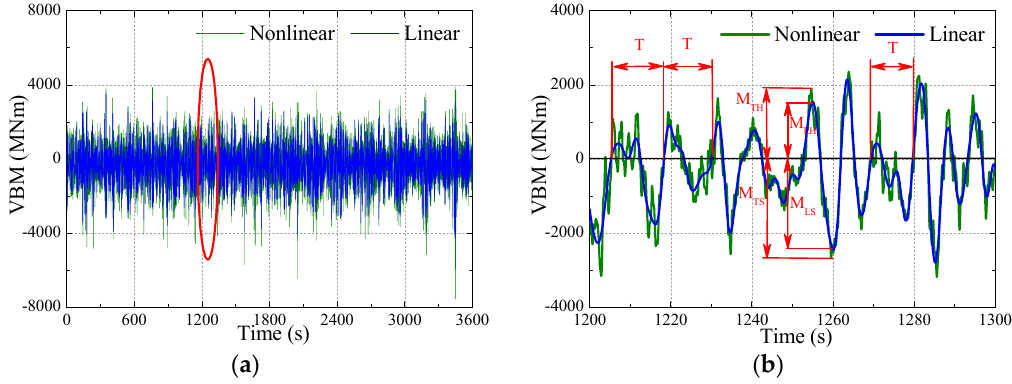
Figure 13. Statistics of peak values from the short-term simulation results. ( a ) The simulated time series in 1 h; ( b ) zoom view of time series in 100 s.